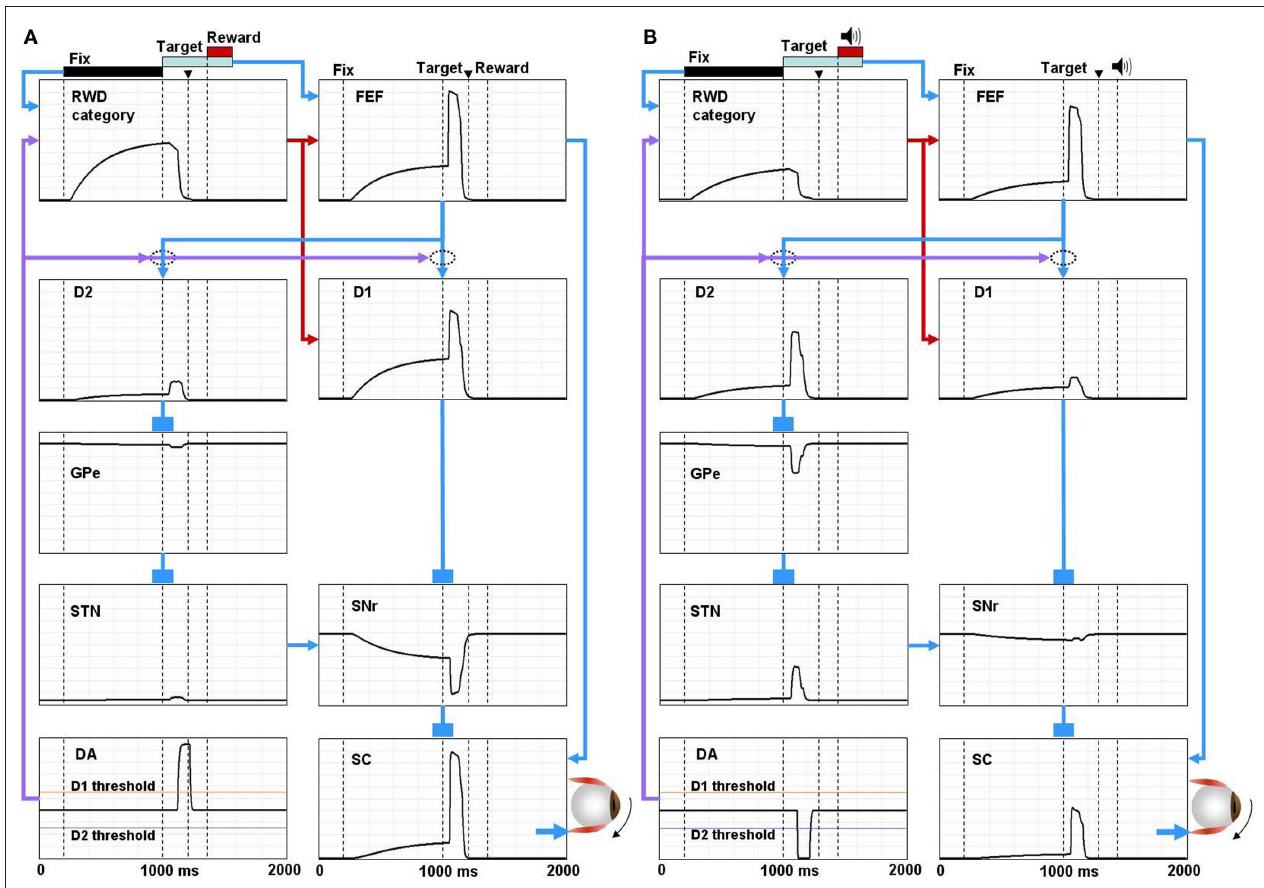
MSN unit (D2) is further depressed by DA-dependent LTD, which is triggered by the DA burst, and mediated by D2 receptors. This results in the suppression of the excitatory input from the STN to the SNr, further enhancing the SC activity. The combined effects from the direct and indirect pathways lead to a shorter latency saccade (see the arrow head on top, indicating the time of saccade initiation). In no-reward trials (B) the activity of the reward-category unit is much weaker, thus lowering the activity of the FEF unit and the direct pathway MSN unit (D1). The activity of the direct pathway MSN unit (D1) is further depressed by DA-independent LTD. In contrast, the activity of D2 MSN increases because DA-dependent LTD is attenuated due to the “pause” of DA activity (DA) and thus is dominated by DA-independent LTP. The combined effects from the direct and indirect pathways lead to a weaker activation of the SC unit and hence a longer latency saccade. The scale of all the ordinate axes is from 0 to